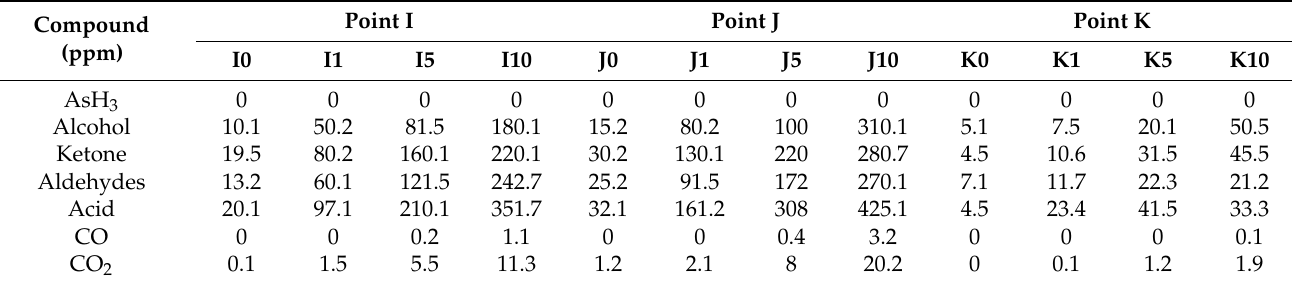
Table 3. Compounds determined in the degassing